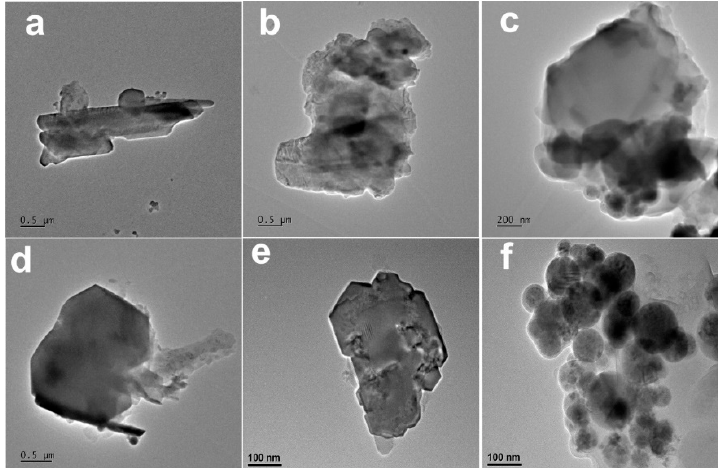
Figure 2. TEM–EDX measurement of individual particles in the glacier snowpack and cryoconite dust in northeast TP, ( a ) aggregated clay mineral and black carbon (BC) particles in LG, ( b ) CaSO 4 mineral aggregated particles in DS, ( c ) Mixed organic matter and aluminosilicate particles in QG; ( d ) Silicate mineral and fly ash aggraded particles in MG; ( e ) Aluminate mineral particles in YG; ( f ) Soot and Fe-rich mineral aggregates in YG. The mixture of mineral and organic and BC also showed LRT source of glacier surface dust.